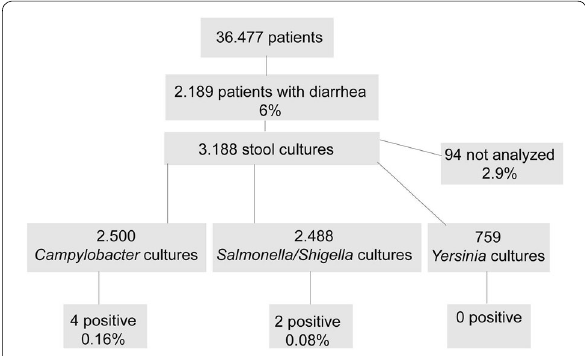
Fig. 1 Flowchart of stool culture analysis at 11 ICUs 2010–2015 at the University Hospital